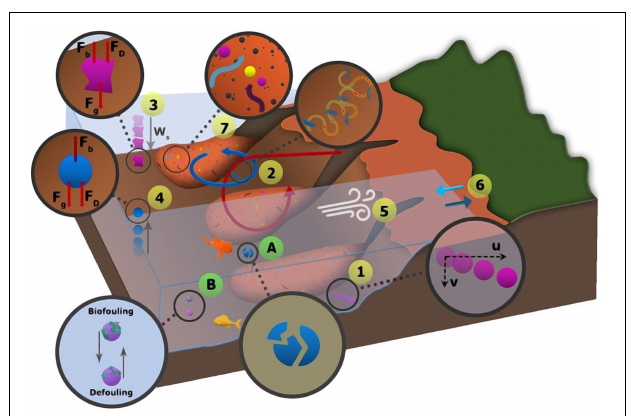
FIGURE 1 | Range of physical processes that affect the transport and distribution of marine MPs (modified from Karimpour et al., 2021a): (1) advection; (2) entrainment by turbulent structures; (3) sinking of negatively buoyant or biofouled MPs, and vertical forces including drag force, F d , gravity, F g , and buoyant force, F b ; (4) rising of positively buoyant or defouled MPs; (5) transport by wind; (6) coastal beaching and wash off; (7) transport with sediment gravity flow. A and B present fragmentation and biofouling, respectively. These two processes are assumed to play significant roles in altering MP transport (Waldschläger et al.,